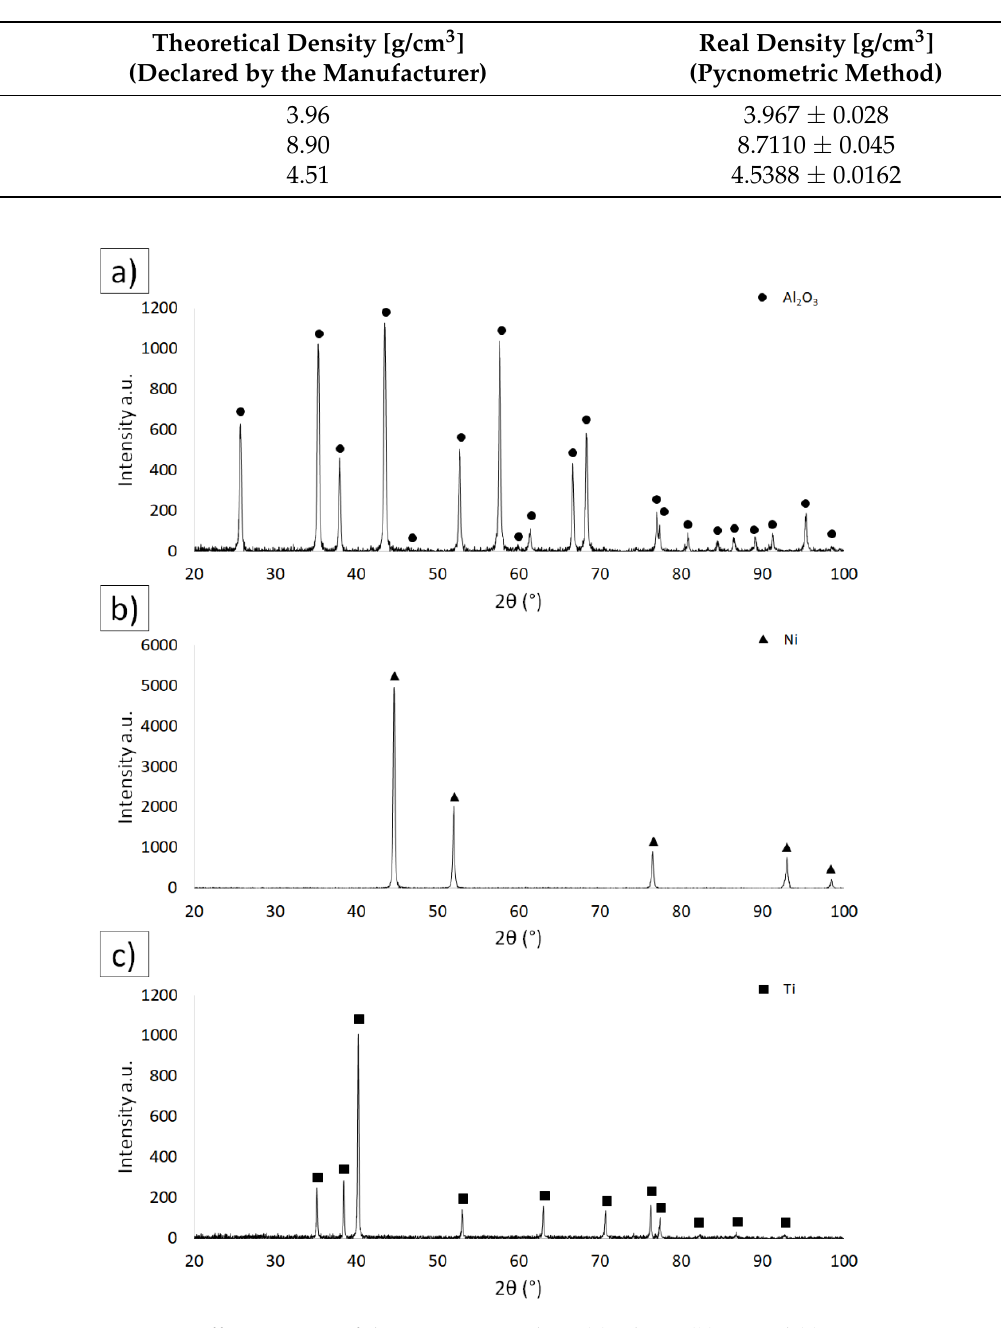
Figure 1. Diffractograms of the starting powders: ( a ) Al 2 O 3 , ( b ) Ni and ( c ) Ti.